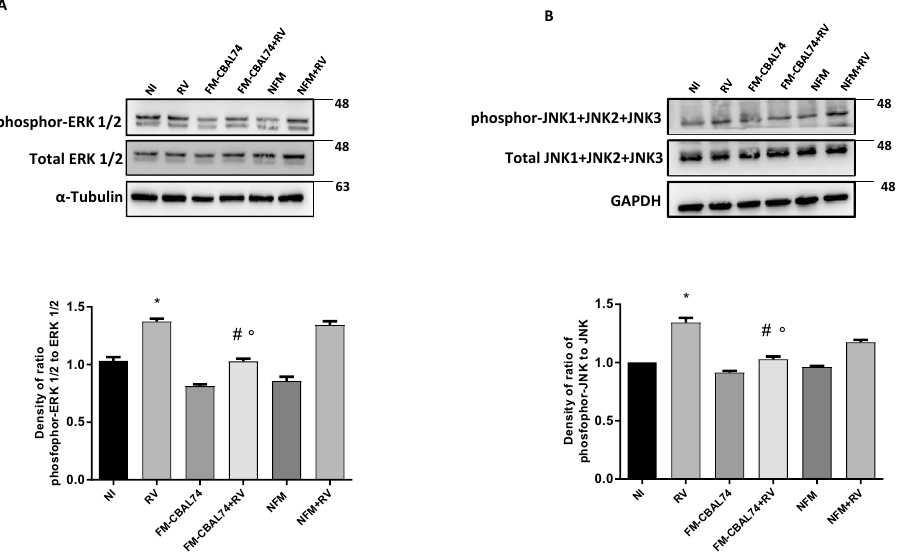
Figure 2. Effects of FM-CBAL74 on MAP kinases pathway activation in Rotavirus -infected human enterocytes. (A,B) Caco-2 cells were infected with RV and pretreated with FM-CBAL74 or NFM for 48 h. Western blot assay of phospho-ERK/total ERK (A) and phospho-JNK/total JNK (B) was performed on protein extracts from Caco-2 cells. RV infection induced MAP kinases ERK, and JNK expression significantly increased compared with non-infected cells. Pre-incubation with FM-CBAL74 (FM-CBAL74 + RV), but not with NFM (NFM + RV), down-regulated this pro-inflammatory pathway in Caco-2 cells. The amounts of these proteins and of β-actin were measured by Western blot. The histogram below shows optical density of the proteins, obtained with Image Lab software. Relative quantification of proteins was normalized versus β-actin protein and was calculated using the ratio between phosphorylated and total proteins. The figure showed representative image of three experiments qualitatively similar. In Supplementary Information 1 is provided the full length WB gels of these proteins.Data represent the means with SD of 3 independent experiments, each performed in triplicateData were analyzed using the one-way ANOVA test. *p < 0.05 vs non-infected cells (NI); # p < 0.05 vs RV-infected cells; °p < 0.05 vs NFM + RV. RV Rotavirus, FM-CBAL74 fermented milk L. paracasei CBAL74, NFM not fermented cow